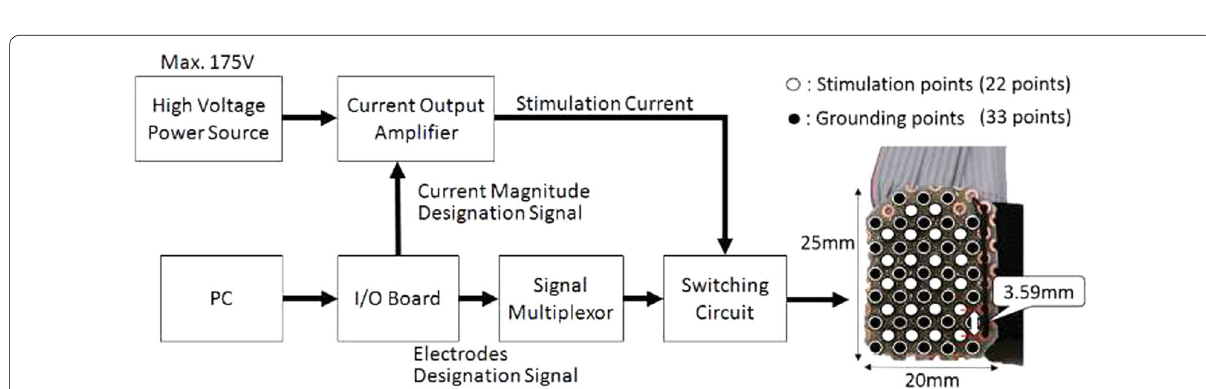
Experiment Experimental setup We conducted experiments of a finger reaching task with and without visual feedback from the movement of the ERT in order to evaluate the level of embodiment of ERT. The task consists on asking the user to move the ERT to touch the tip of one of four fingers of the left hand (index, middle, ring or pinkie). The finger to touch is randomly